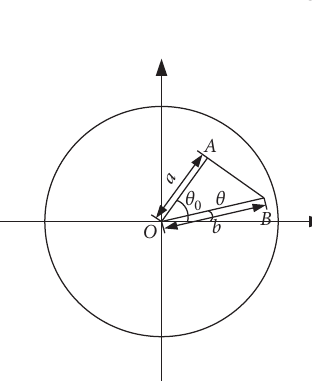
Figure 3: The force analysis of the section.